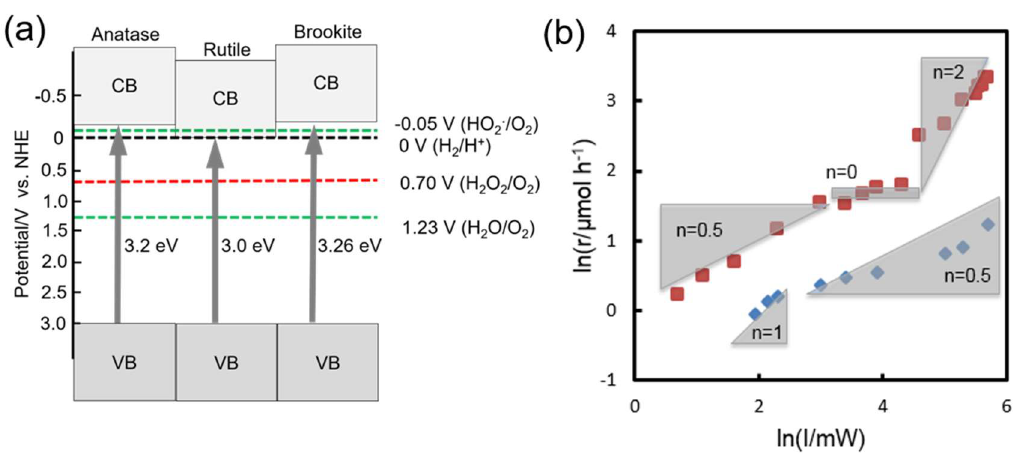
Figure 8. ( a ) Schematic diagram of possible oxygen reduction reactions of titania and ( b ) light-intensity dependence (LID) of photocatalytic activities of titania (ST-G2, blue) and FCP-loaded titania (r-c-S , red).